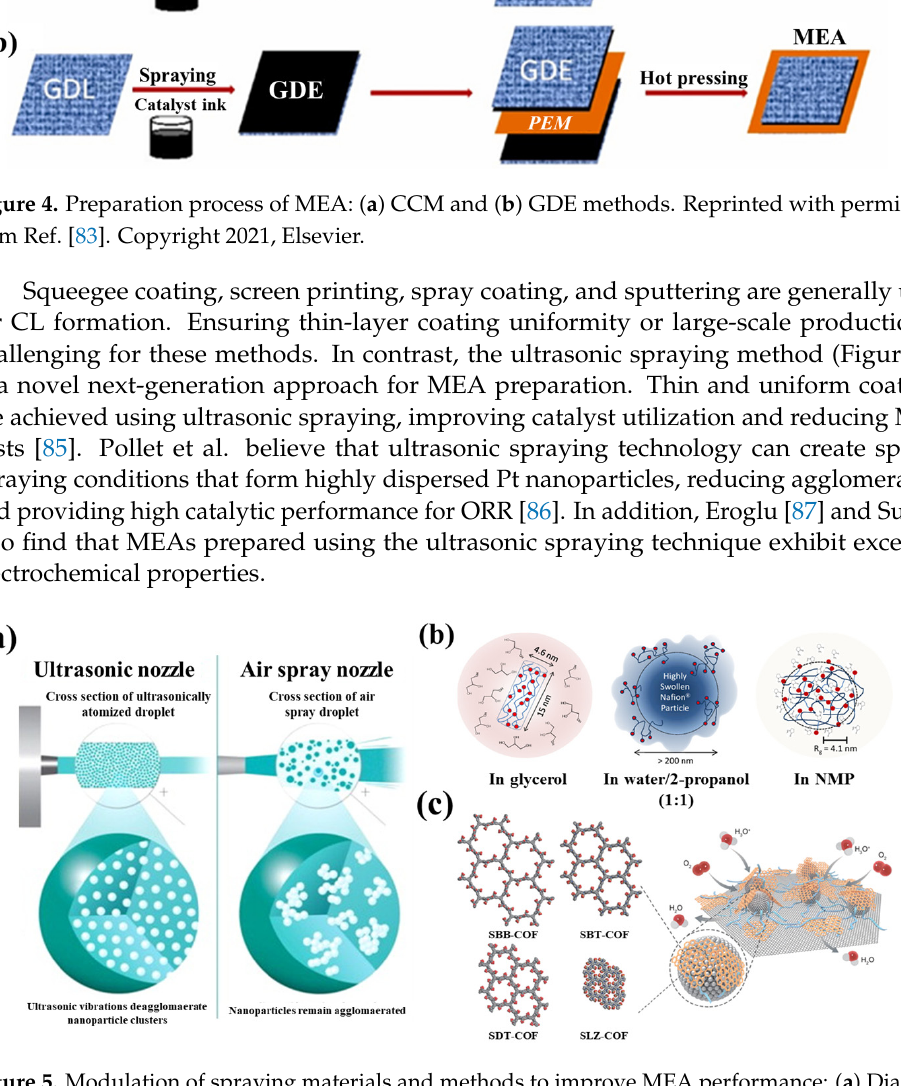
Figure 5. Modulation of spraying materials and methods to improve MEA performance: ( a ) Diagram of the ultrasonic spraying method. Reprinted with permission from Ref. [85]. Copyright 2010, Elsevier. ( b ) Dispersion of Nafion in different solvents. Reprinted with permission from Ref. [89]. Copyright 2012, ACS. ( c ) Modulation of the ionomer to optimize the structure of the three-phase interface. Reprinted with permission from Ref. [90]. Copyright 2022, AAAS.